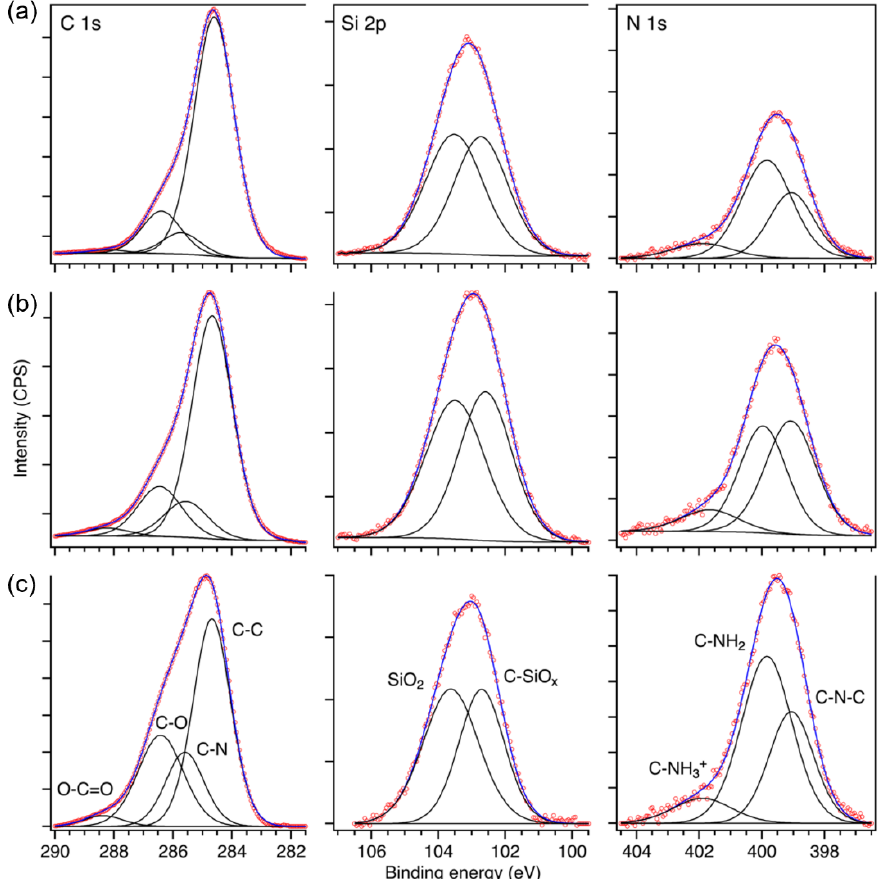
Figure 3. Deconvoluted C 1s, Si 2p, and N 1s XPS spectra of epoxy – silica coatings prepared with different DETA/DGEBA ratios: ( a ) D0.3, ( b ) D0.4, and ( c ) D0.6.